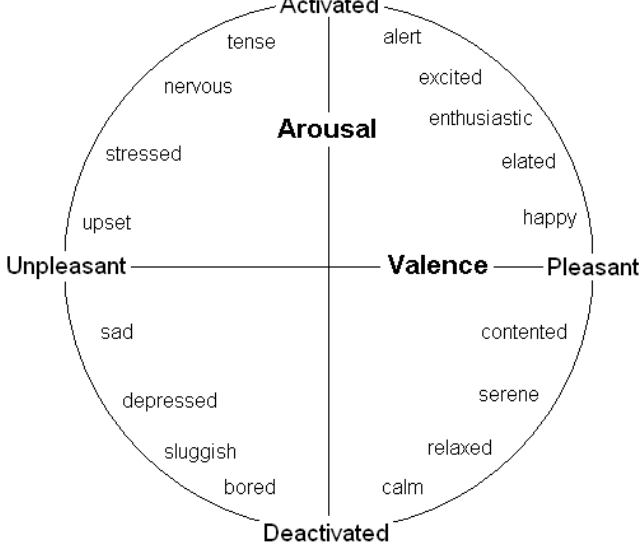
Figure 22. The 2D valence-arousal emotion space